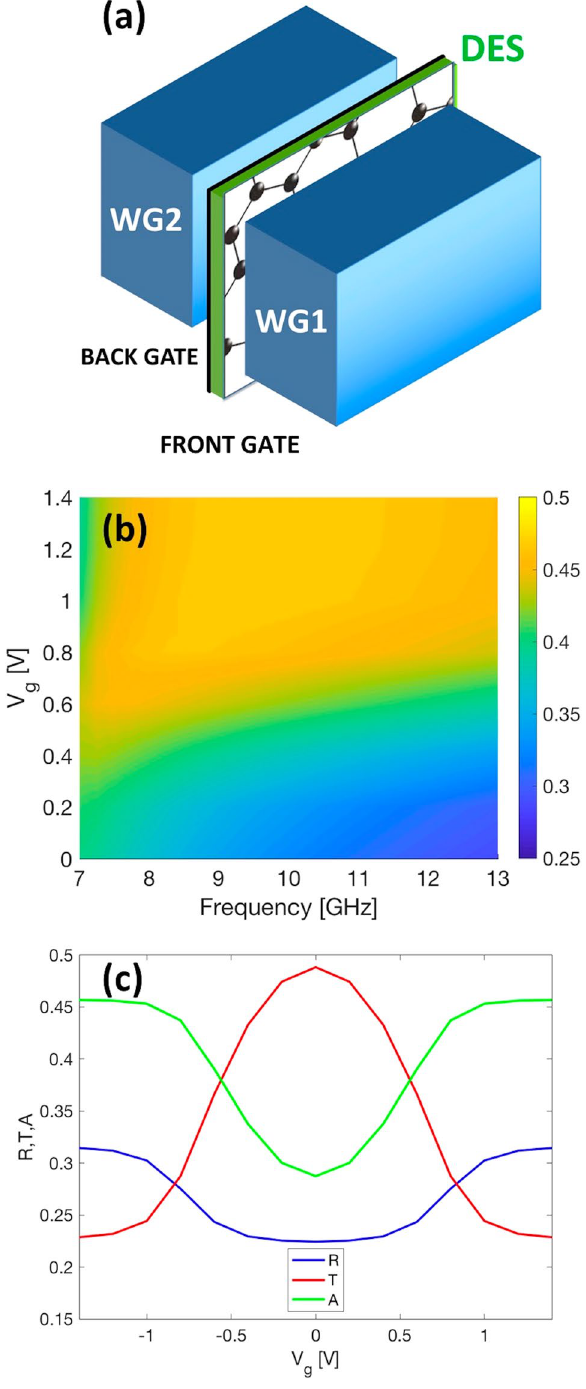
Figure 3. ( a ) Sketch of the numerical model consisting of the graphene-based capacitor sandwiched between two WR90 waveguides (WG1 and WG2). ( b ) Numerical absorption map in the frequency range of interest. ( c ) Numerical reflectance, transmittance and absorbance when the gate voltage is varied in the DES electrochemical window at 13